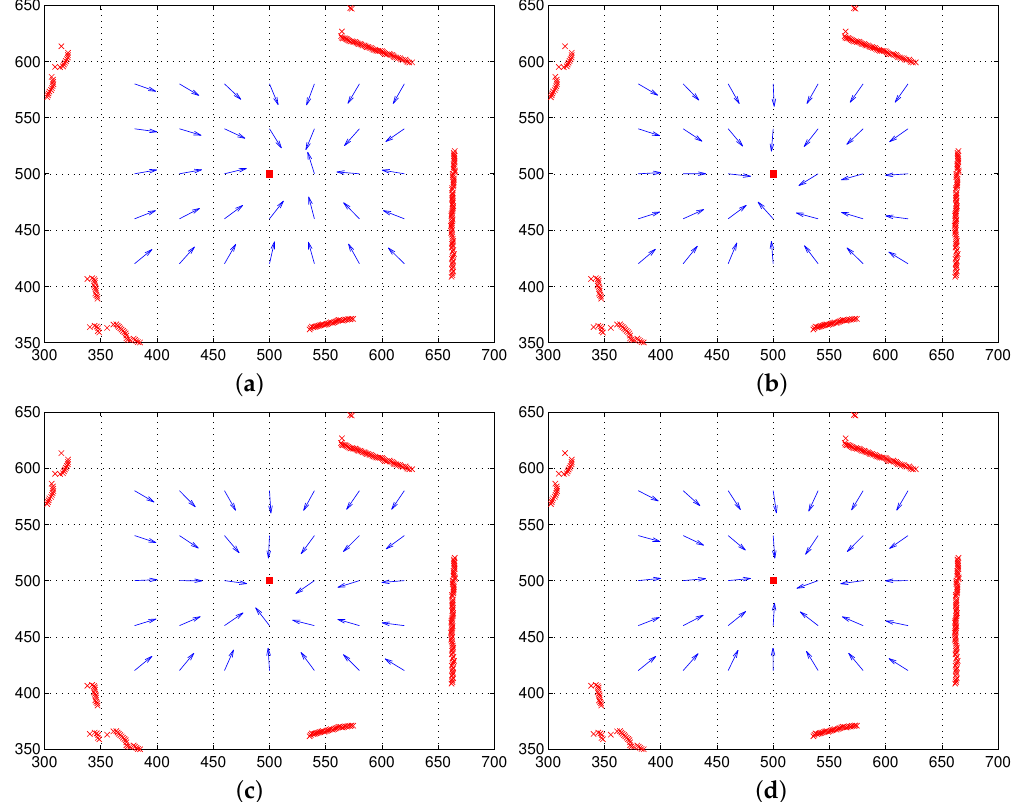
Figure 10. Homing performance with various feature values: ( a ) C i is the blue color intensity; ( b ) C i is the red color intensity; ( c ) C i is the V intensity in HSV space; ( d ) C i = 1 or 0 depending on the √ H 2 + S 2 + V 2 > 50, C i = 1, otherwise C i = 0); the red box at discretized condition with HSV (if (500,500) indicates home, and arrows show the homing direction at each